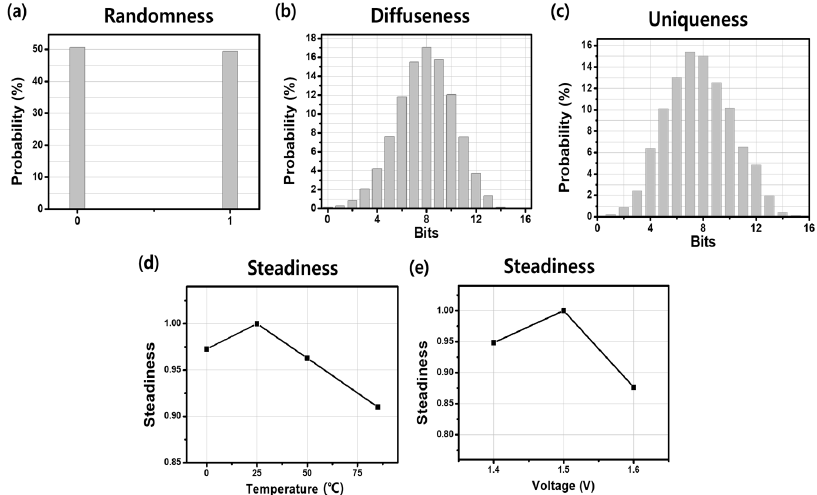
Figure 6. pm-PUF performance evaluation: ( a ) randomness, the occurrence probability of a “0” and “1” in the responses; ( b ) di ff useness, the possibility of generating di ff erent responses with the same challenge; ( c ) uniqueness, the possibility of generating different responses among different PUFs; and ( d , e ) steadiness under ( d ) temperature and ( e ) voltage variations.